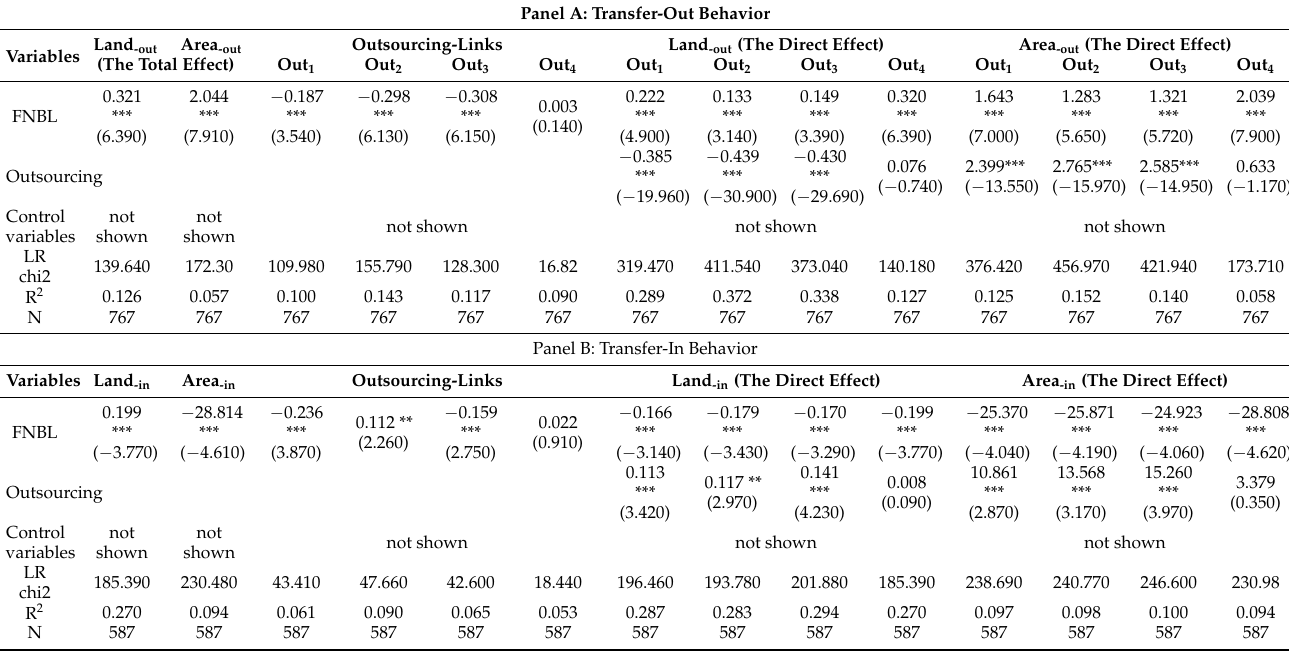
Table 6. The mediating effect of the different production links service outsourcing. Panel A: Transfer-Out Behavior